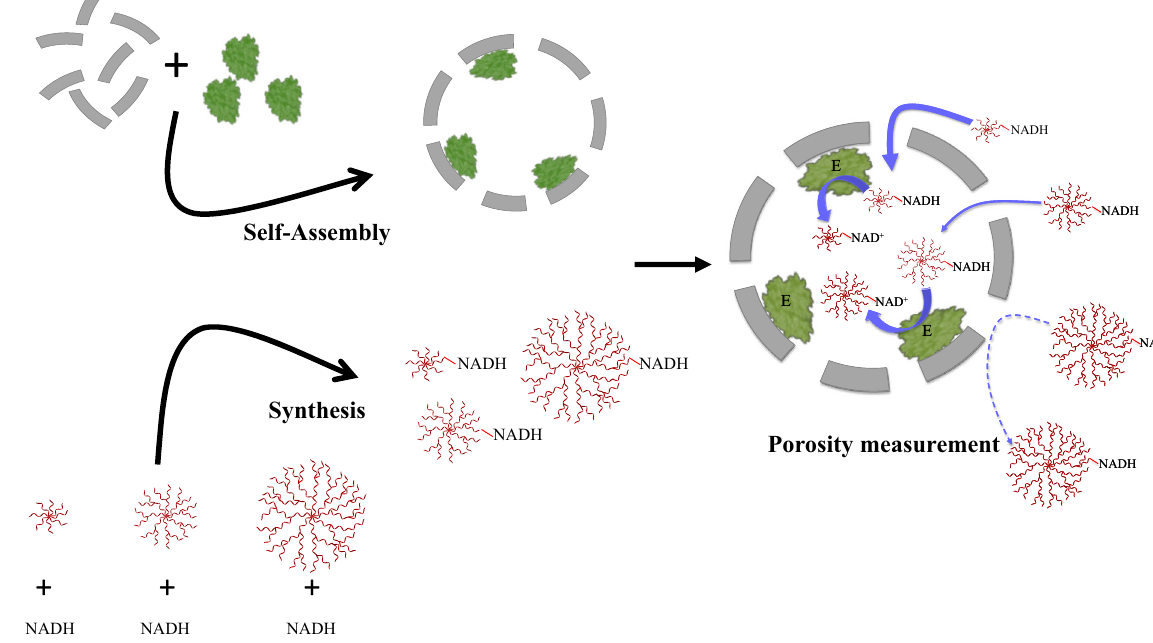
Fig. 1 Scheme of our experiments. P22 particles self-assembled with coat protein (CP = gray) and scaffold protein (SP)-enzyme fusion (AdhD-SP = green). NADH was synthesized to yield NADH-dendrimer conjugates (red). The porosity of P22 particles was probed by using the various NADH- dendrimer molecules as bait for the AdhD enzyme. If the “ bait ” accessed the interior of the particle, we saw the redox reaction (NADH → NAD + ).